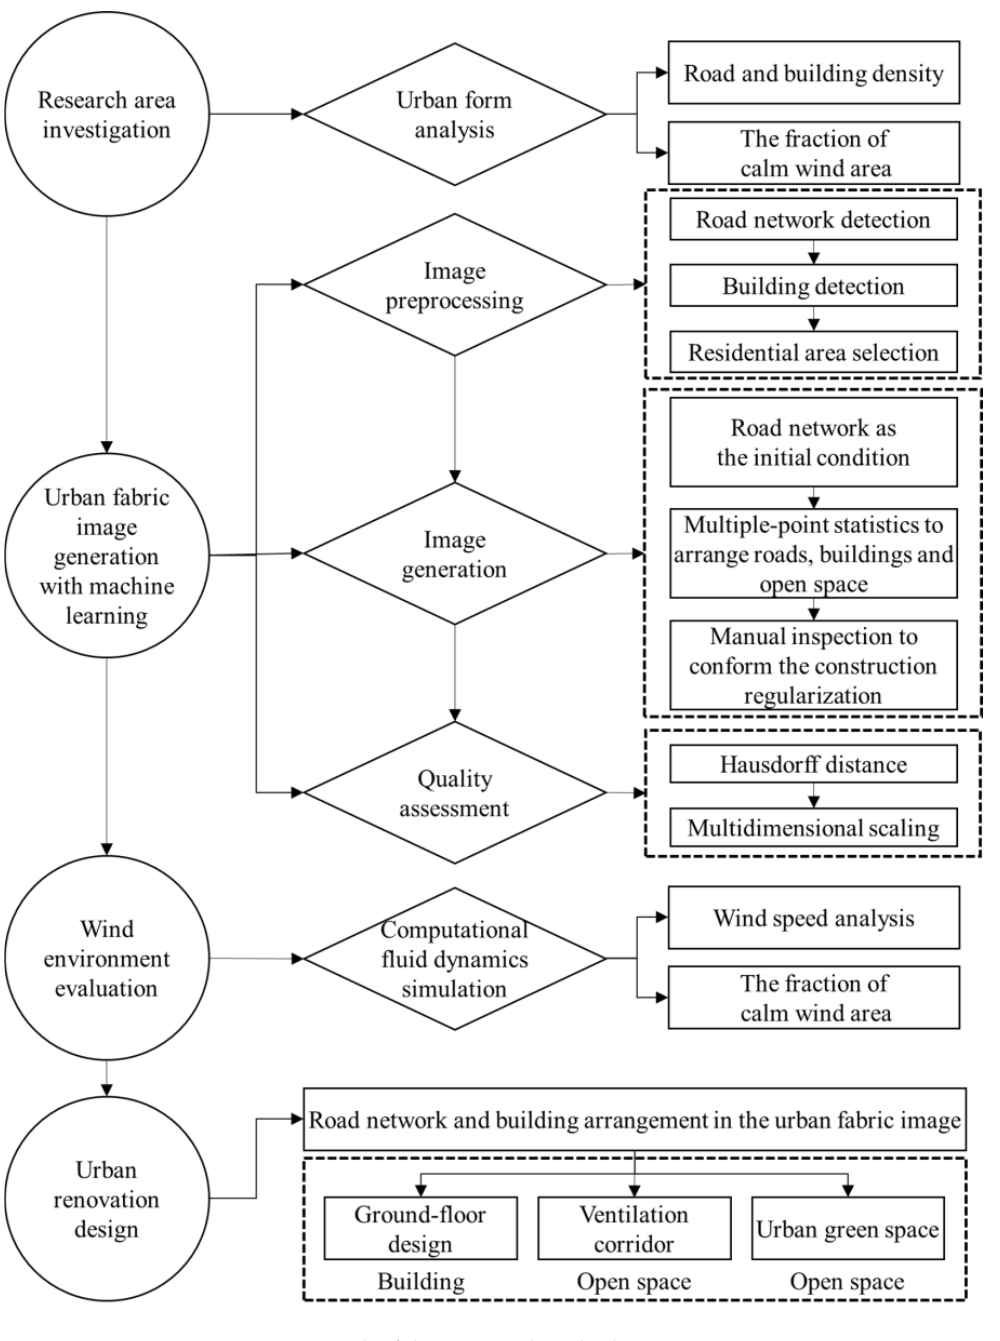
Figure 4. Framework of the proposed method.